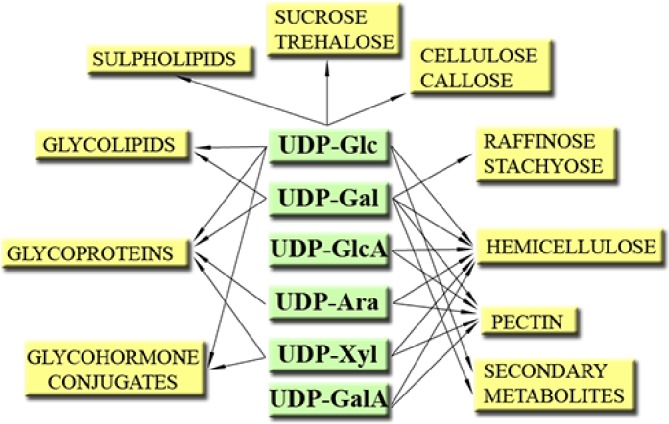
Some roles of UDP-sugars in plants. Modified from Kleczkowski et al. (2011a).